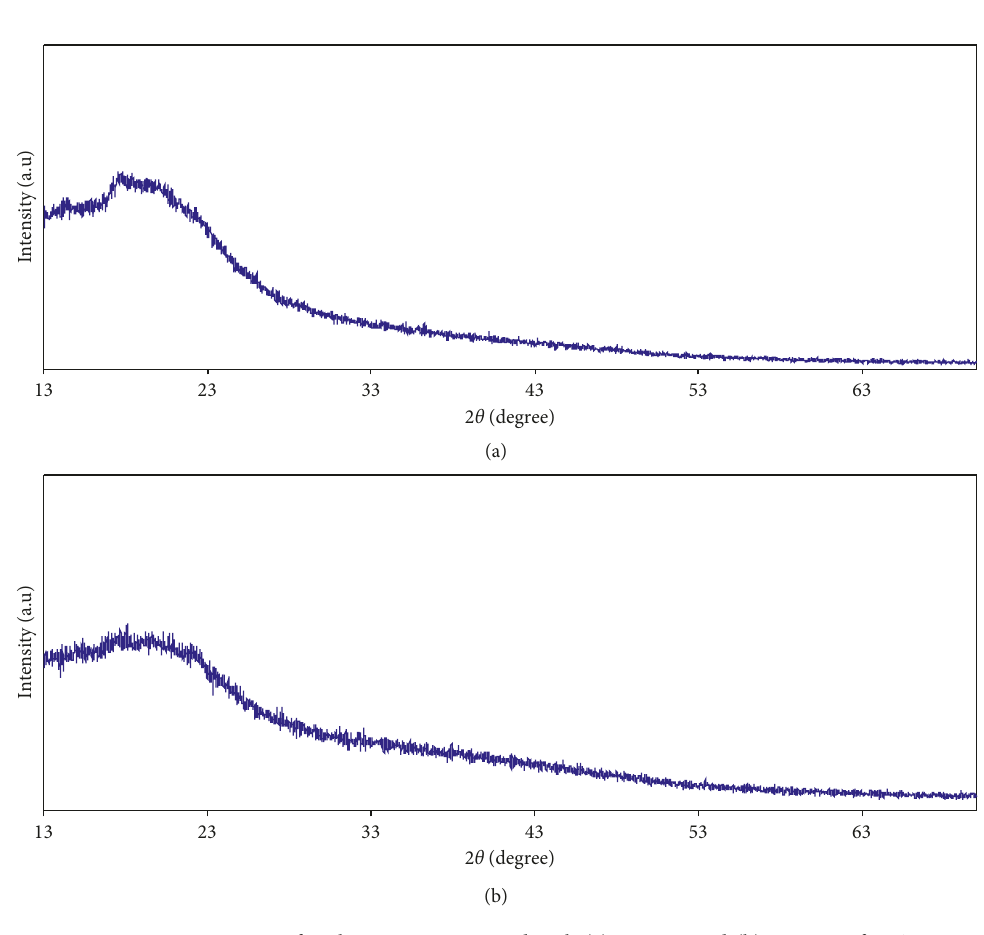
Figure 2: XRD pattern for chitosan incorporated with (a) 15wt.% and (b) 45wt.% of POZ.